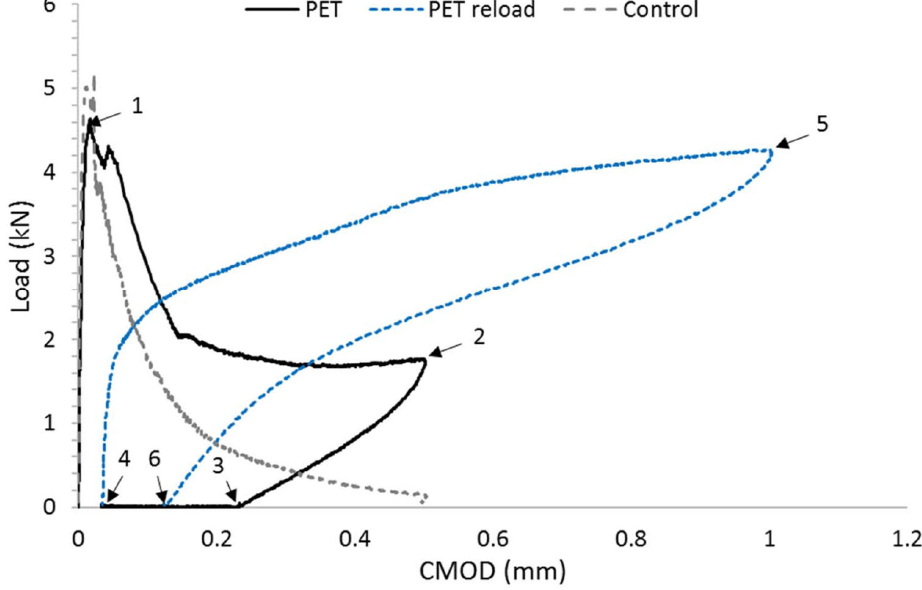
PET tendons were used both as the sole means of reinforcement and in conjunction